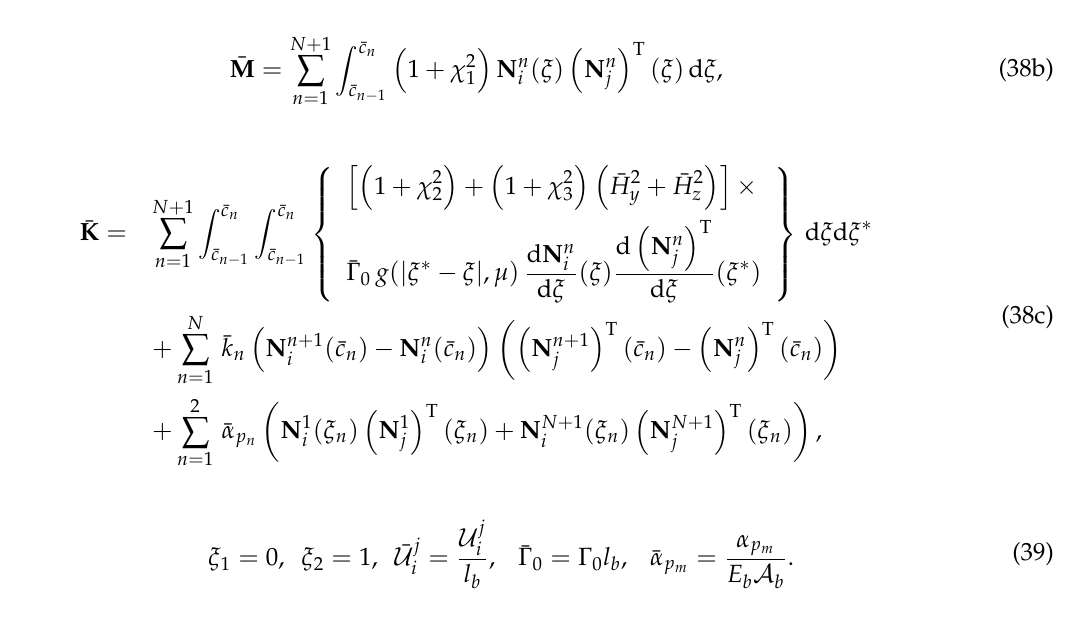
Verification of the predicted first six dimensionless frequencies by the proposed nonlocal-differential-based model and those obtained by the model of Hsu et al. [82] for both fixed–fixed (FIFI) and fixed–free (FIFR) ends ( l b = 20 nm, c 1 = 4.004 nm, ¯ k 1 = 8.7413, e 0 a = 0, χ 2 Conditions